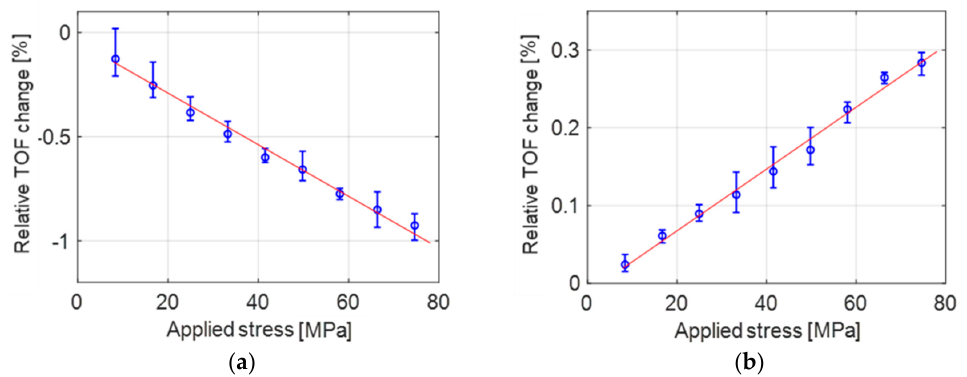
Figure 11. Change rates of the TOF with respect to the applied stress in specimen SA.1 for measurements of ( a ) K 1 and ( b ) K 2 .